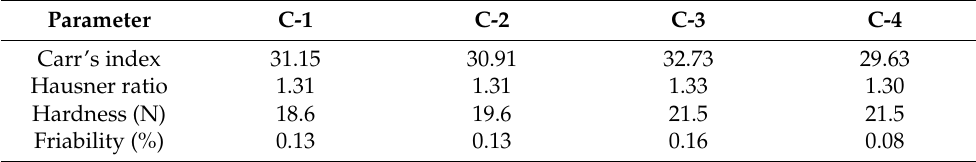
Table 5. Granule and tablet characteristics of EMP-loaded mini-tablet core formulas.